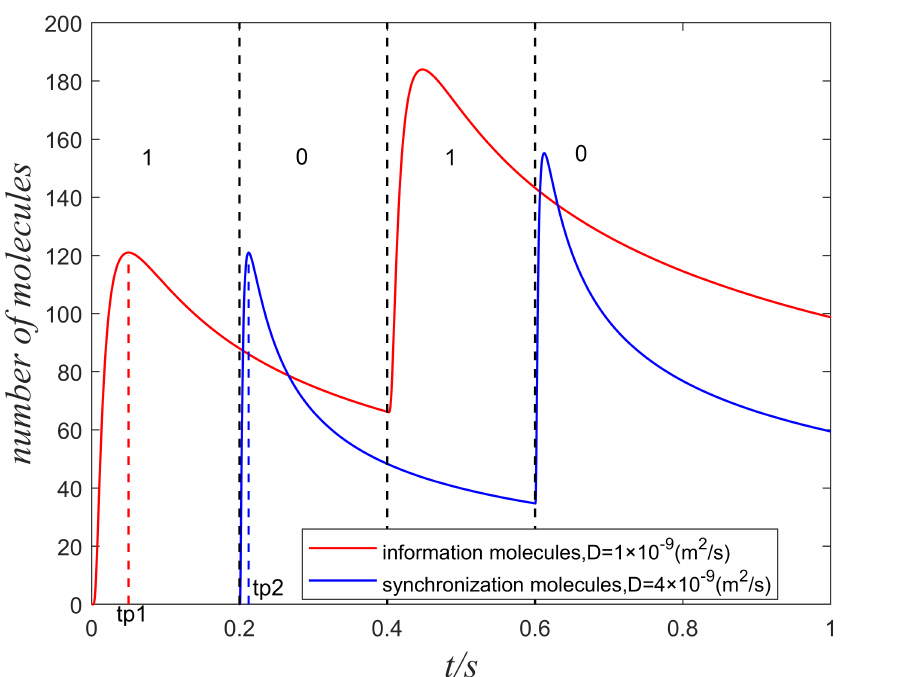
Figure 2. The information molecules and synchronization molecules with different diffusion coeffi- cients are transmitted along with symbol sequences 1010, where information molecules are released at the start of symbol “1”, while the synchronization molecules are released during the symbol “0”. t / s denotes that the unit of time is